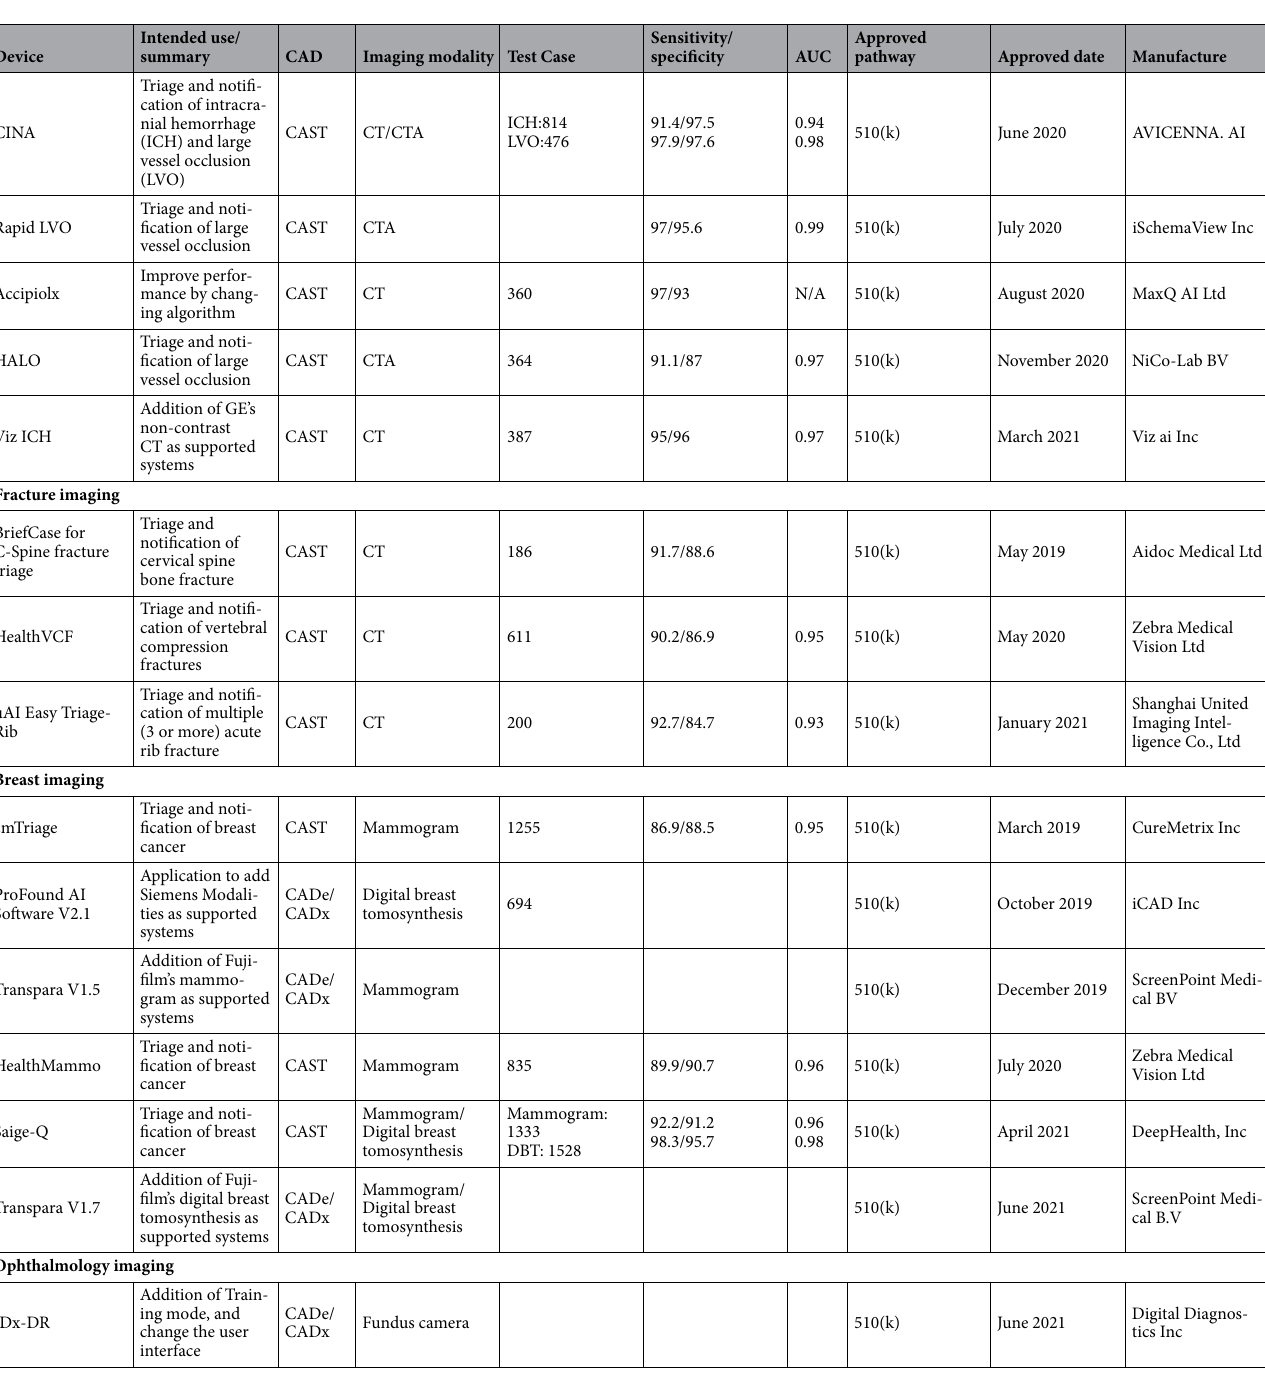
Table 1. Characteristics of the 35 FDA approved AI/ML-based CAD evaluated by standalone software